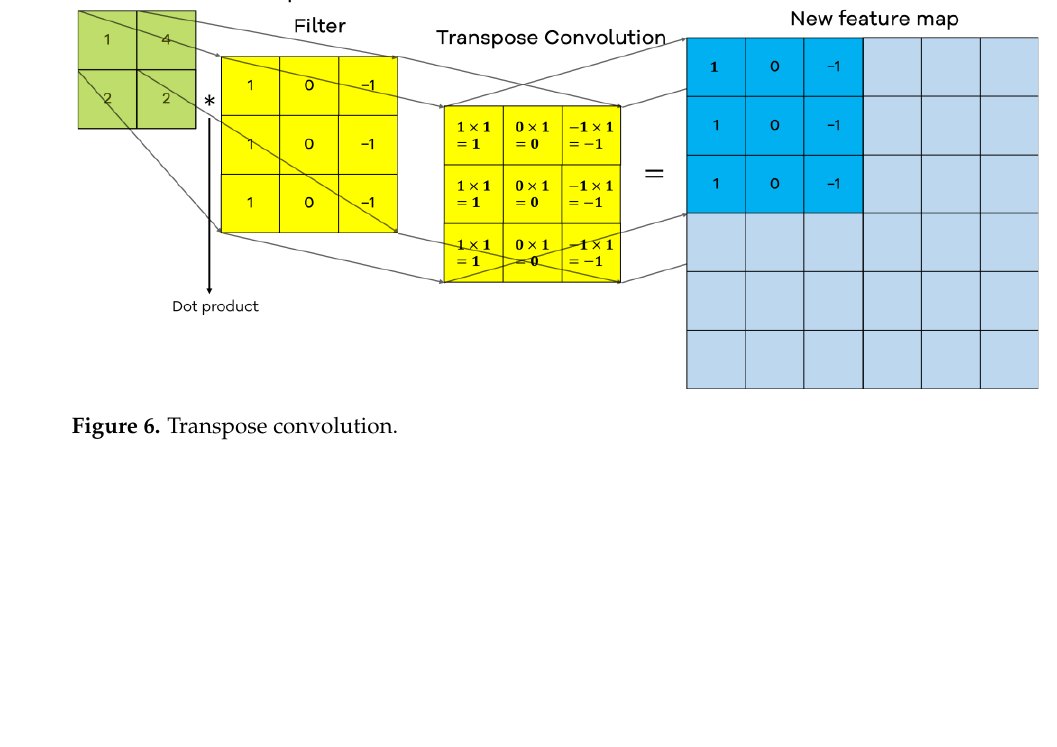
Figure 7. U-Net architecture. 2.2.2. DeepLabV3+ The main feature of DeepLabV3+ is the modified, aligned Xception backbone and the ASPP module. Chen et al. [17] modified the Xception [34] by adding more layers, extra batch normalization, and ReLu after every depthwise separable convolution operation. The modified Xception structure is illustrated in Figure 8. Depthwise separable convolu- tion consists of a depthwise convolution and a pointwise convolution [34]. The depthwise convolution performs the convolution operation using a different filter on every channel. While the pointwise convolution simply performs a single-pixel dot product as illustrated in Figure 9. This reduces the computation cost compared to standard convolution and is very effective in a large network such as the DeepLabV3+. Depthwise separable convolu- tion is illustrated in Figure 8. The ASPP module uses depthwise atrous separable convolution of different rates, pointwise convolution with 256 feature channels, and average pooling. All layers from the ASPP module were concatenated and passed to the decoder. In the decoder, the feature map was further concatenated with information from the earlier layer of the encoder. Fi- nally, a simple two-times convolution and bilinear upsampling were implemented. Illus- tration for DeepLabV3+ is depicted in Figure 10.